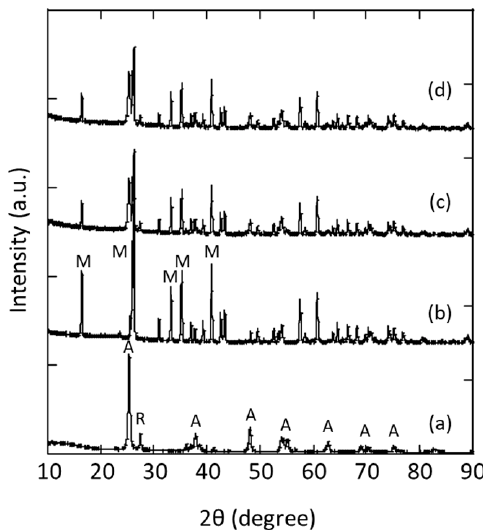
Figure 4. XRD patterns: ( a ) P25 powder, ( b ) mullite support, ( c ) TiO 2 membrane, ( d ) TiO 2 /Ag mem- brane.